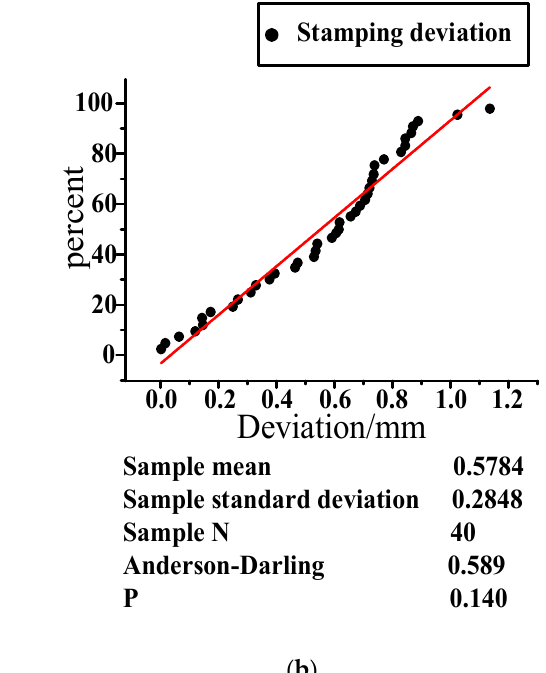
Figure 17. Original and add 1.4 mm . 3.3. Analysis of X2 Using the 6 Sigma Method 3.3.1. Measurement X2 represents the thickness of the glass. The manufacturing of automobile glass is extremely complicated and must conform to certain standards. We take a group of 60 glass samples to test, and measure the thickness of automobile glass. Minitab was used to create